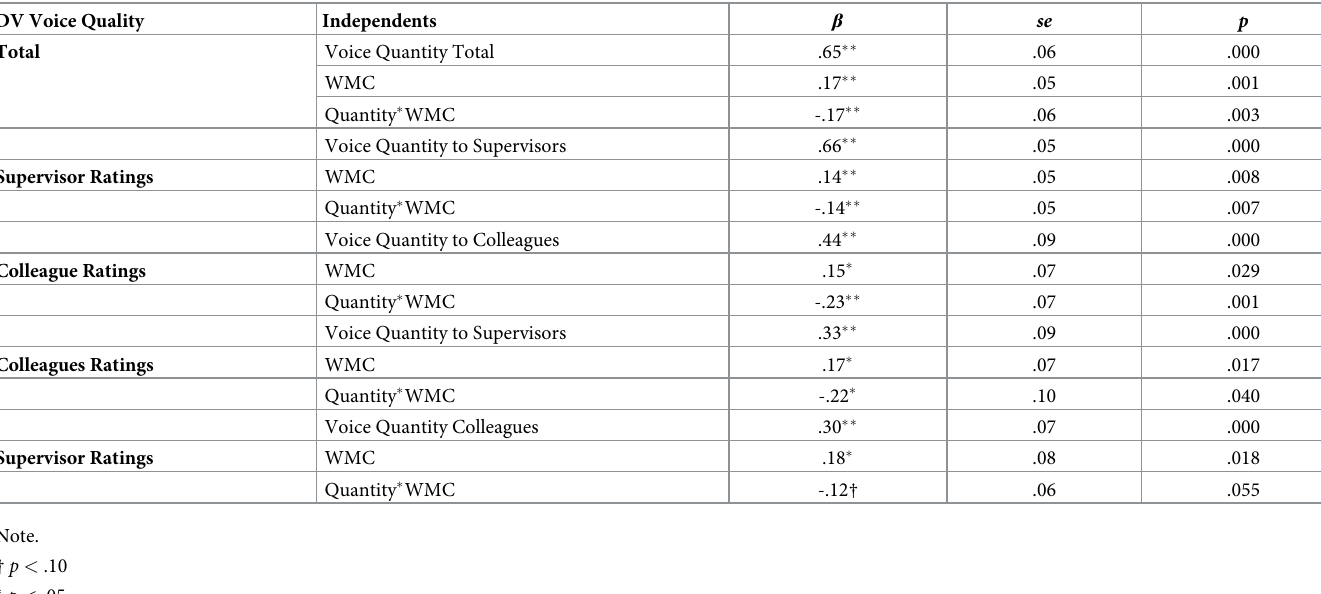
Table 1. All interaction models with dependent variable voice quality.